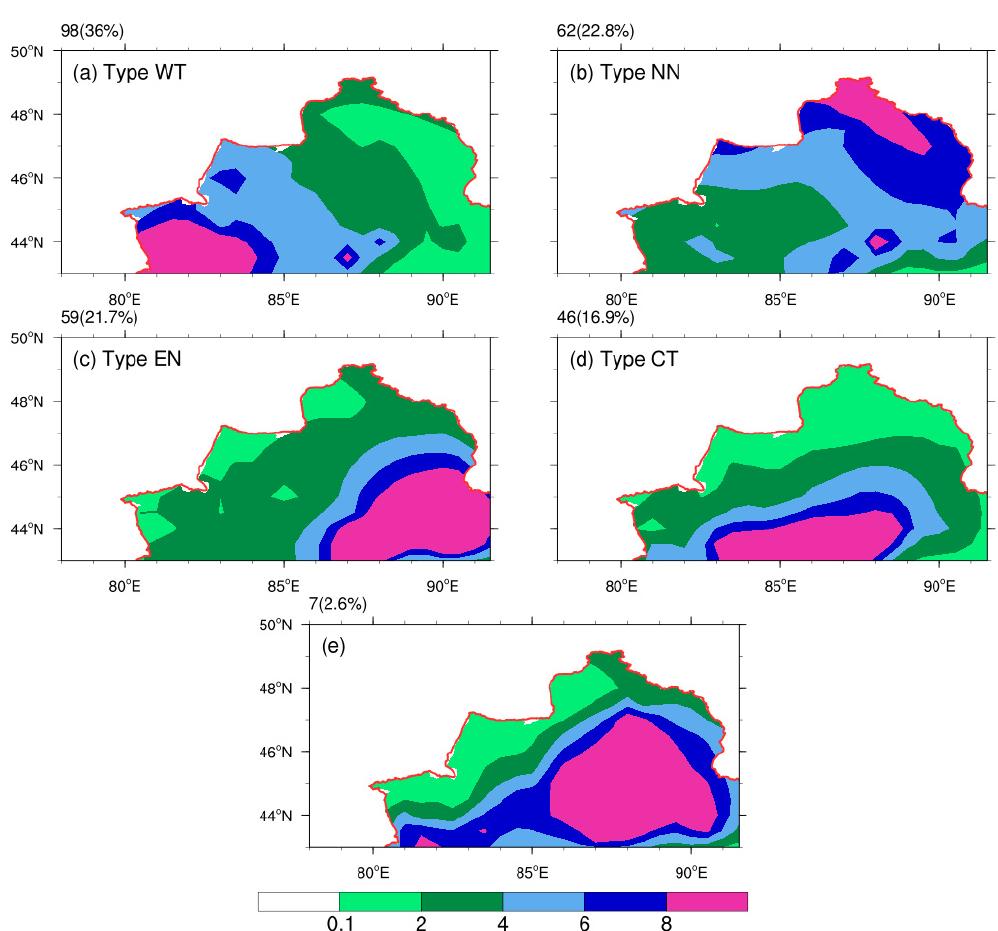
Figure 3. Results of the objective classification of daily precipitation of extreme process precipitation in the Northern Xinjiang region during summer in 1979–2018 (Unit: mm). The number on the upper left represents the number and percentage of occurrences. ( a ) Type WT; ( b ) Type NN; ( c ) Type EN; ( d ) Type CT; ( e ) Type 5.